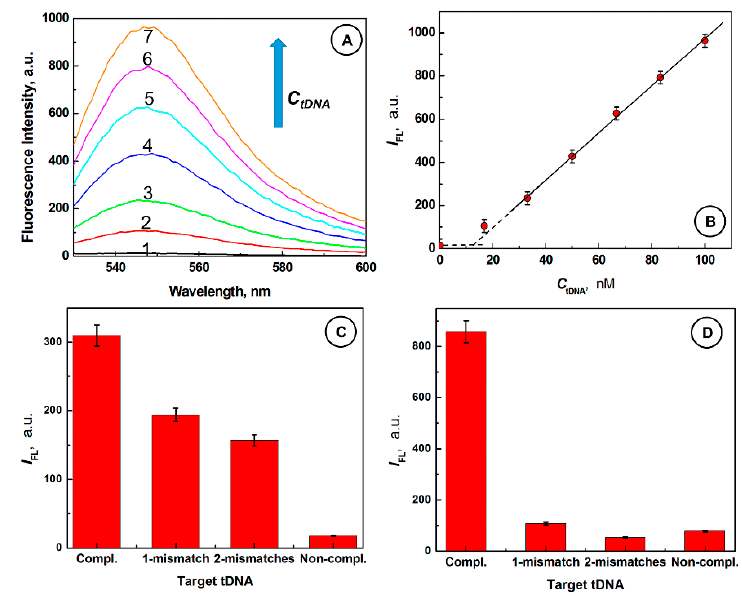
Figure 3. ( A ) Fluorescence spectra for SurMB-Joe@GO ensembles after addition of complementary t DNA with different concentrations, C t DNA (nM): (1) 0, (2) 16.7, (3) 33.3, (4) 50, (5) 66.7, (6) 83.3, (7) 100; ( B ) Dependence of fluorescence peak intensity I FL vs. C tDNA ; ( C , D ) Comparison of fluorescence peak intensities for SurMB-Joe@GO ensembles upon addition of a complementary target, targets with 1- and 2-mismatches, and non-complementary oligonucleotides at the temperatures: ( C ) 37 °C and ( D ) 61 °C; Conditions: C SurMB = 100 nM; C GO,ring = 370.8 µM; buffer: 10 mM PBS, pH 7.4, room temp. ( A , B ), temperature scan from 22 °C to the indicated temperature ( C , D ).